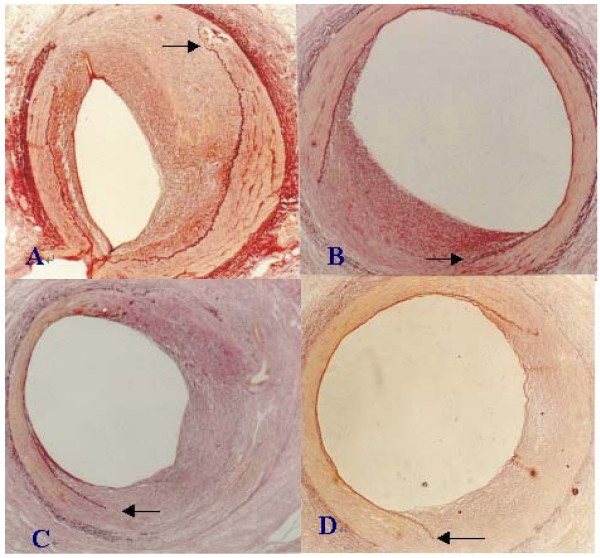
Representative histological cross sections of coronary arteries 4 weeks after balloon injury (Verhoeff-van Gieson elastin stain, ×50). A: Control; B: Probucol; C: LXS; D: HXS. Disruption of the internal elastic lamina (←) was similar at the site of intimal reaction in all groups. Significant reduction of intimal hyperplasia was observed in groups treated with drugs, especially in HXS, compared with control.